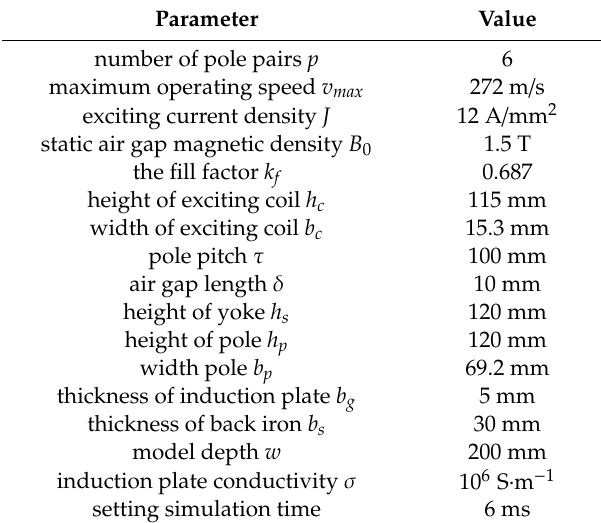
Table 2. Basic parameters of the eddy current braking model.